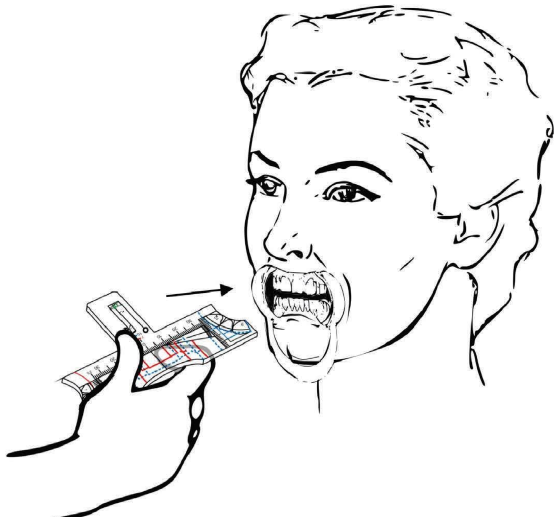
Figure 8: Invention handling illustration of the ideal individual proportion drawings on the lateral aspect of the